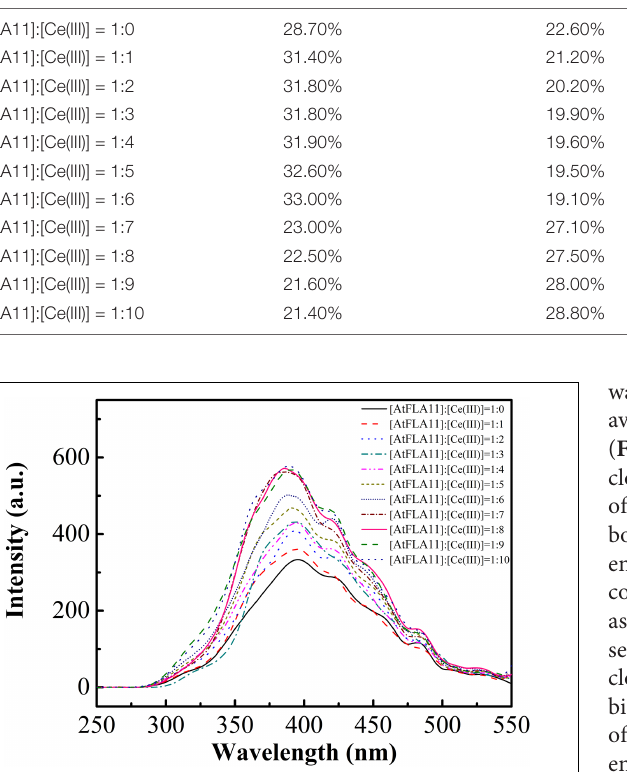
Frontiers in Plant Science |